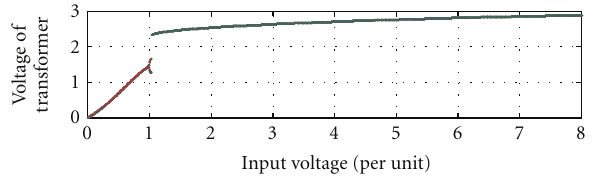
Figure 9: Time domain simulation for q = 7 (neutral resistance e ff ect).